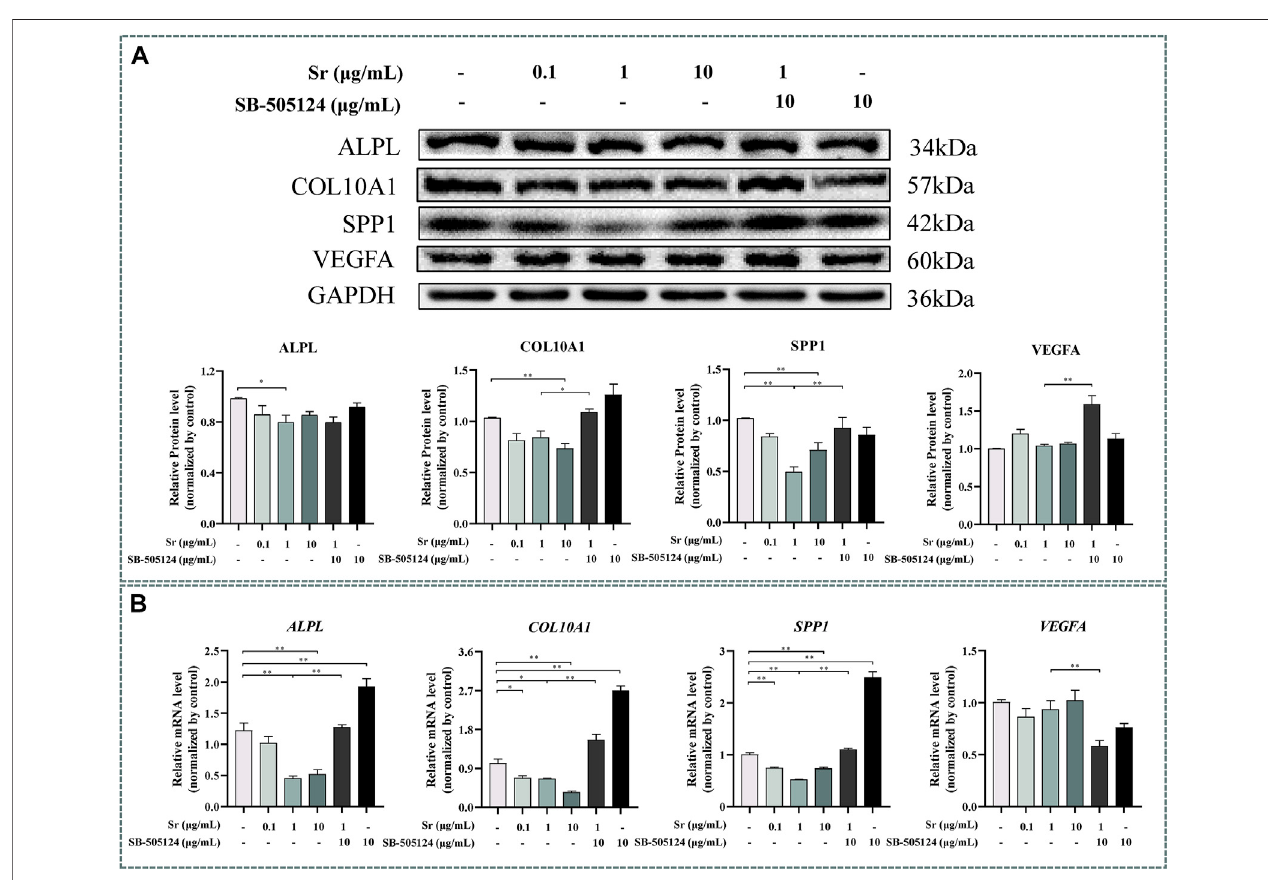
FIGURE6 | Effects of Srand SB-505124 on differentiation-related factors inbovinechondrocytes. Chondrocytes were treated withdifferentdoses ofSr (0, 0.1, 1, 10 μ g/ml) with or without activin receptor-like kinase 5 (ALK5) kinase inhibitor (10 μ M SB-505124). (A) Western blot and protein expression levels of secreted phosphoprotein 1 (SPP1), alkaline phosphatase(ALPL),vascular endothelialgrowth factor (VEGFA), and type Ⅹ Collagen α 1(COL10A1). (B) mRNA expression levels of SPP1, ALPL, VEGFA, and COL10A1. All experiments were repeated at least thrice. Data are means ± SEM ( n = 3 in each group) * p < 0.05; ** p <